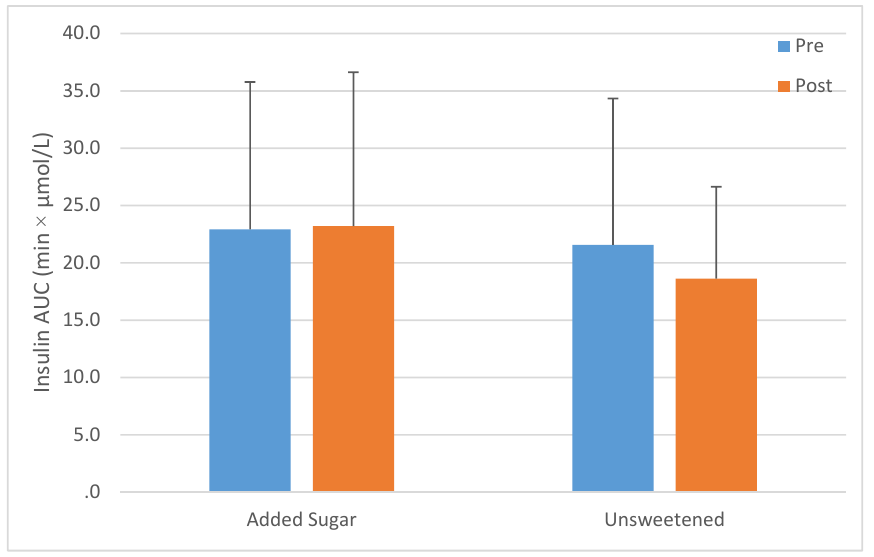
Figure 2. Change in insulin Area Under the Curve (AUC) after ten weeks’ consumption of low-fat milk sweetened with a sugar ( n = 72) or unsweetened ( n = 21); interaction p > 0.05.